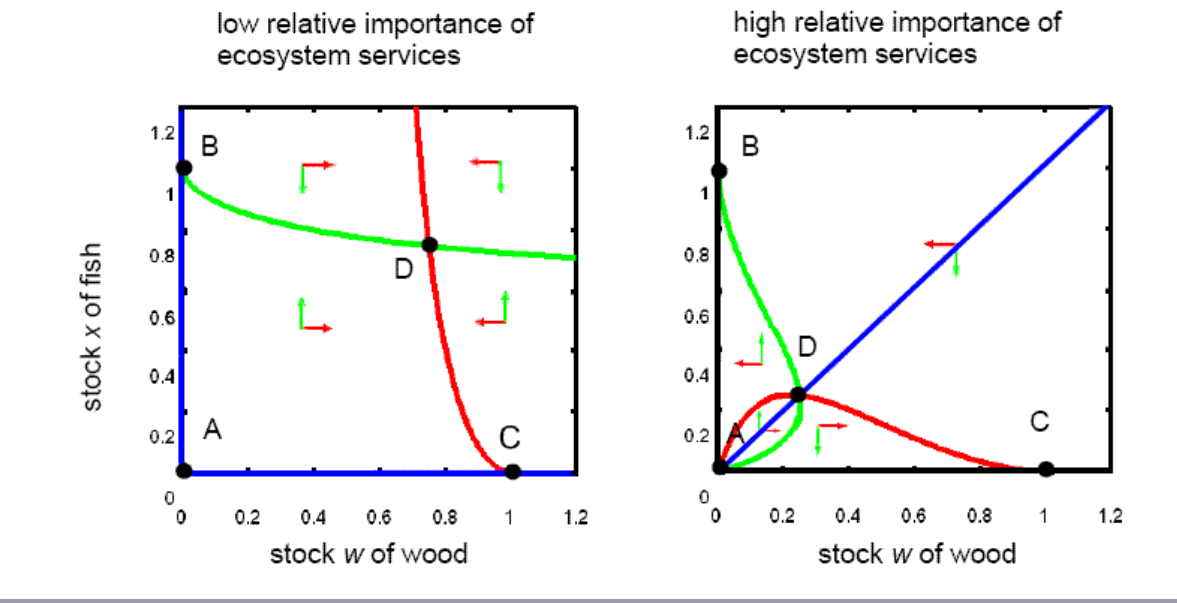
Fig. 4. Phase diagrams for the ecosystem's dynamics under open access and profit-maximizing harvesting for different levels of relative importance of ecosystem services, a . Dynamics are characterized by dx/dt > 0 (< 0) left (right) of the green line, and dw/dt > 0 (< 0) below (above) the red line. Blue lines indicate saddlepaths. In both diagrams, A is an unstable equilibrium. In the left diagram, relative importance of ecosystem services is low ( a = 0.25) and D is an (almost) globally stable equilibrium, whereas B and C are only saddlepoint-stable. In the right diagram, relative importance of ecosystem services is high ( a = 0.75) and D is only saddlepoint-stable while B and C are locally stable, the corresponding basins of attraction consisting of the areas northeast (B) and southwest (C) of the saddlepath. Parameter values for both diagrams: r x =